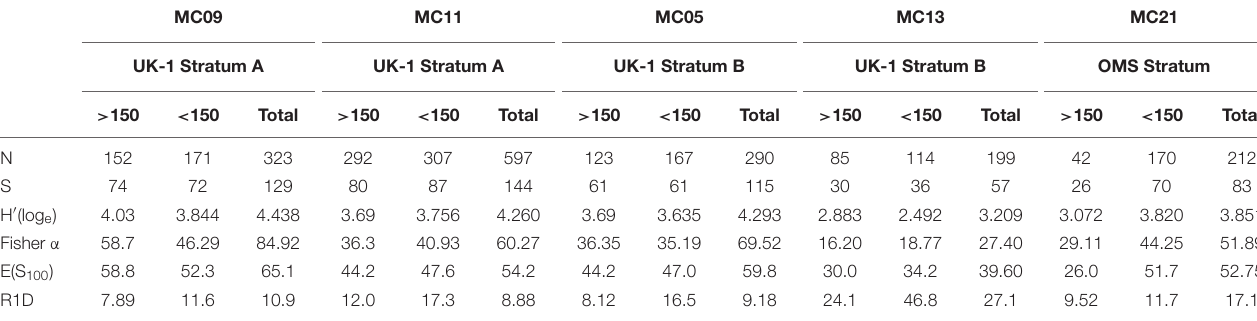
TABLE 8 | Diversity metrics for the stained assemblage in different